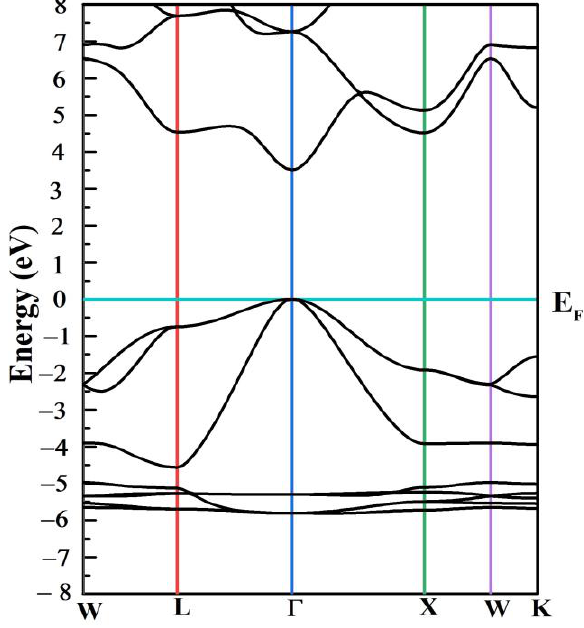
Figure 9. Computed electronic band structure of ZnS.